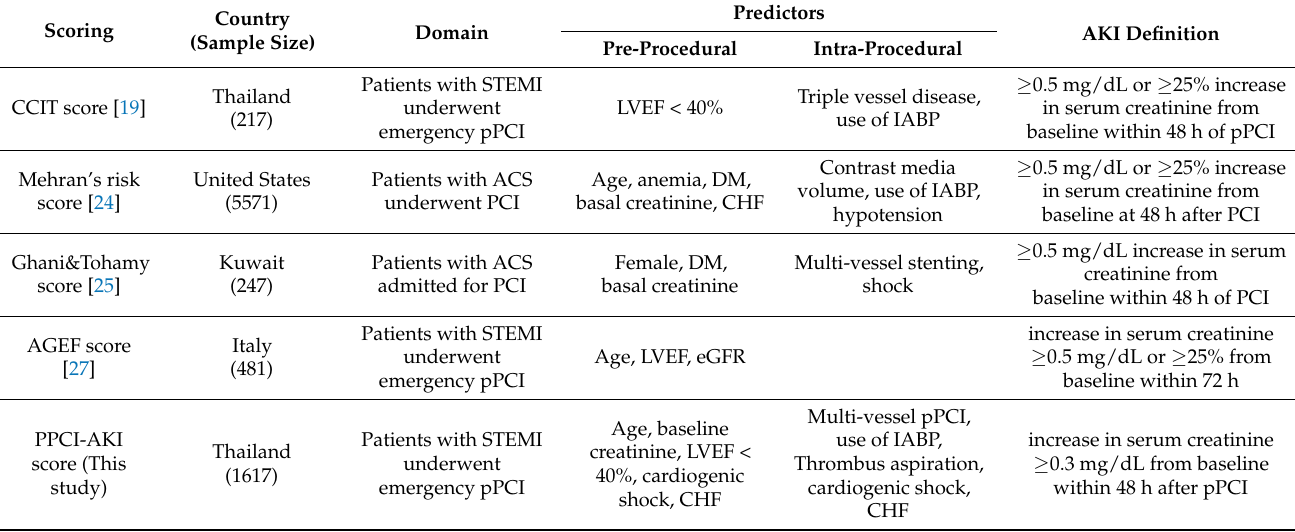
Table 5. Methodological characteristics of clinical scoring systems used for comparative validation in this